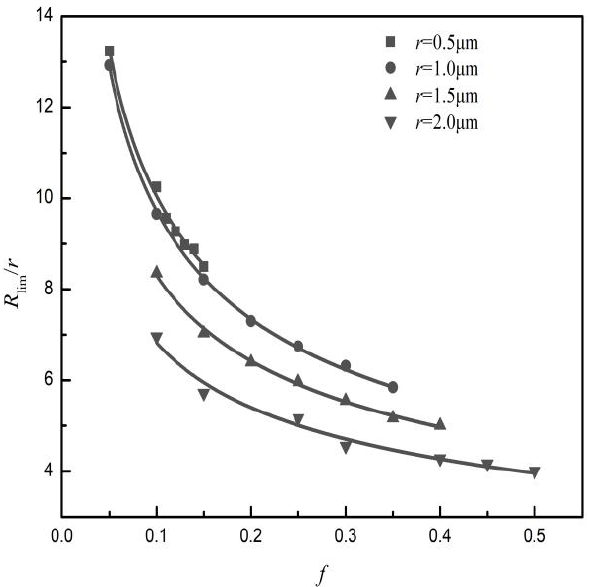
Figure 9. Ratio of the average grain size and second-phase particle size, R lim /r , versus the second- phase particle volume fraction, f.